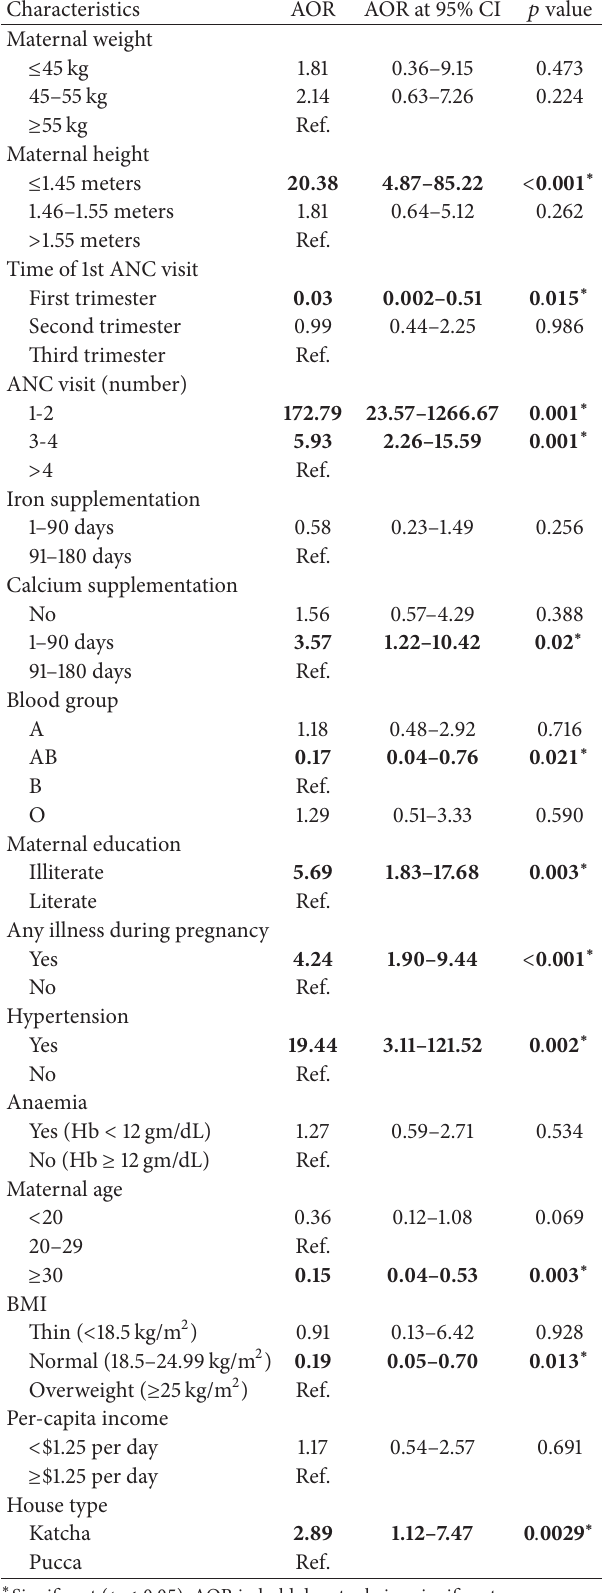
Table 3: Multivariate regression analysis for possible predictors of